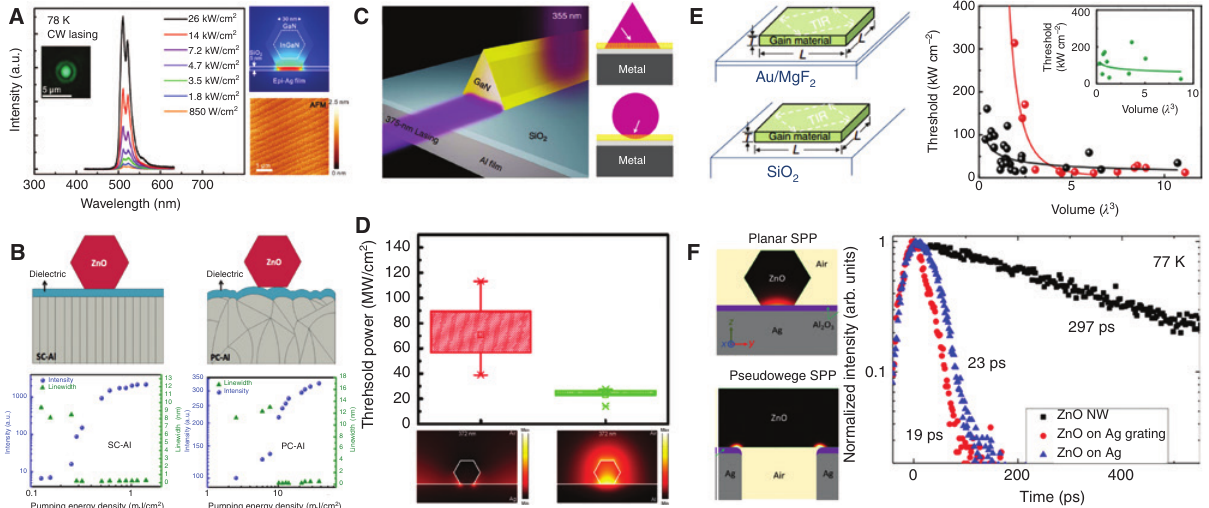
Figure 4: Threshold reduction in plasmonic NW lasers. (A) Left: lasing spectra of the InGaN@GaN/SiO /Ag device pumped by a CW 405 nm laser. Inset: the far-field laser spot. Right: energy-density 2 distribution in the plasmonic nanolaser and atomic force microscopy (AFM) image showing that Ge-capped Ag film remains atomically smooth in air. Reproduced with permission [154]. Copyright 2012, American Association for the Advancement of Science. (B) Top: schematic of the ZnO NWs on the tops of the single-crystalline and polycrystalline Al films with a dielectric spacer layer. Bottom: emission intensity and line width as functions of the pumping fluence in the two devices. Reproduced with permission [184]. Copyright 2016, Springer Nature. (C) Left: schematic of the GaN NW/SiO /Ag device. Right: effective gain area (yellow area) in two types of semiconductor-insulator-metal interface. 2 Reproduced with permission [155]. Copyright 2014, Springer Nature. (D) Top: average threshold comparison for ZnO/Al and ZnO/Al O / 2 3 Al nanolasers. Bottom: calculated electric field profiles of ZnO/Ag and ZnO/Al structures for 372 nm. Reproduced with permission [157]. Copyright 2016, American Chemical Society. (E) Left: schematic of plasmonic laser (CdS/MgF /Au) and photonic laser (CdS/SiO ). Right: laser 2 2 threshold versus device volume for plasmonic (black dots) and photonic (red dots) nanolasers with thicknesses in the range 100–150 nm. Inset: laser threshold versus device volume for plasmonic nanolasers with thicknesses below 100 nm. Reproduced with permission [185]. Copyright 2017, Springer Nature. (F) Left: simulated local Purcell factors of planar and pseudo-wedge SPP nanolasers. Right: carrier dynamics of ZnO NWs on flat Ag and Ag gratings at 77 K. Reproduced with permission [186]. Copyright 2018, American Chemical